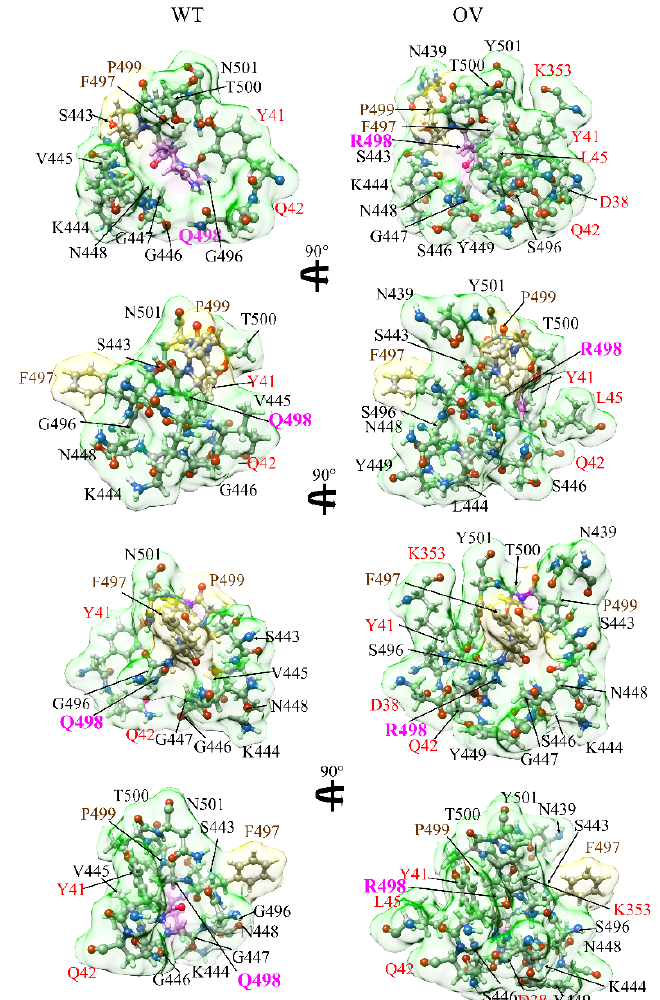
Figure 3. Interaction change due to mutation at site 498 for both WT (left) and OV (right). The surface of site 498 is marked in magenta color. The surfaces of its NN AAs and NL AAs are shown in yellow and green, respectively. Visible NN and NL AAs are marked near their surface in brown and black, respectively. NL AAs from ACE2 are marked in red. We can see considerable changes in NL AAs and their shapes due to mutation.